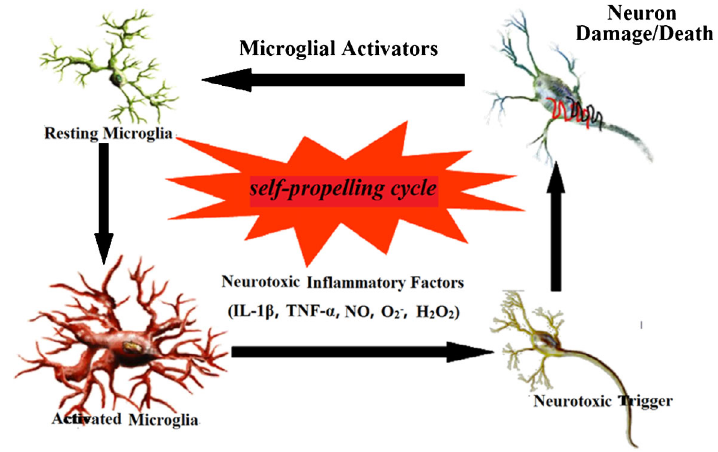
Figure 7. Diagram of changes in microglial appearance and function in the resting and activated